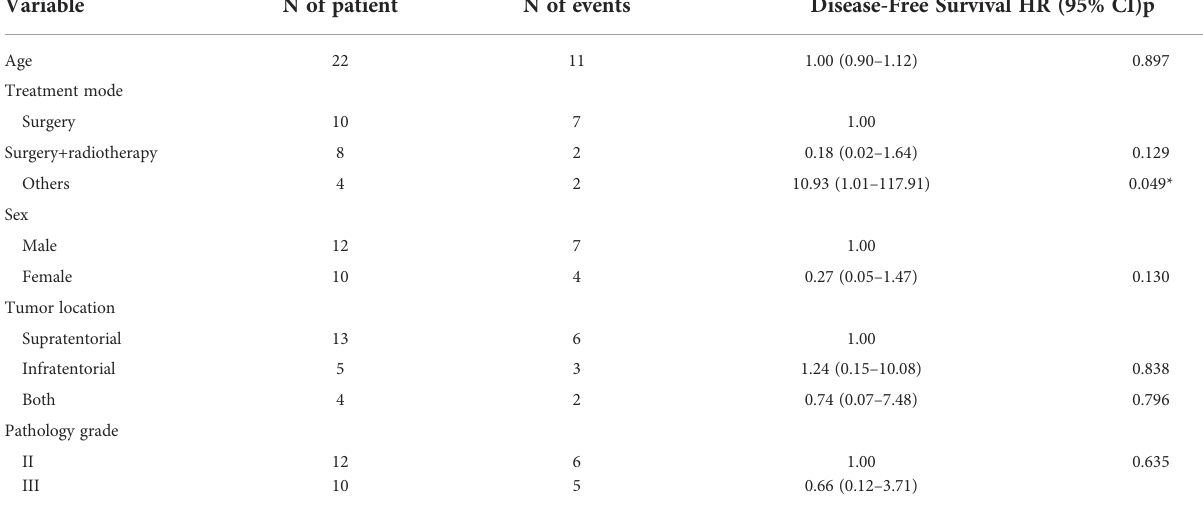
TABLE 3 COX regression analysis of factors associated with time to progress in patients with recurrent SFT/HPC. Variable